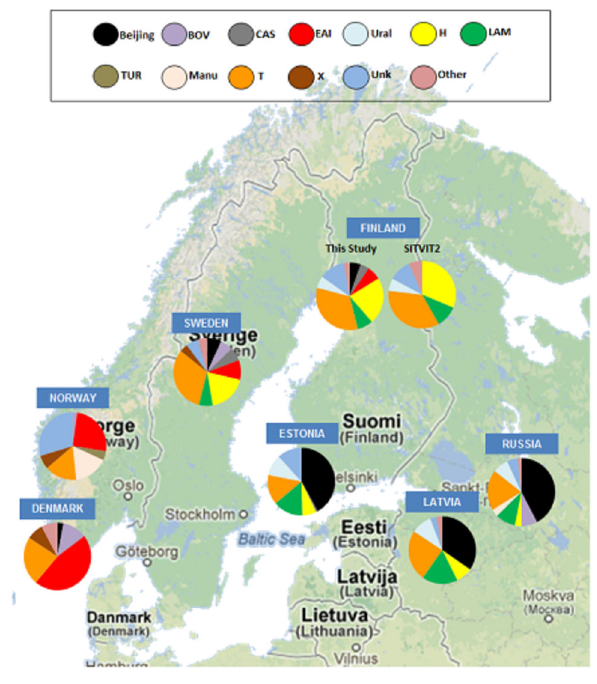
Figure 2. Phylogeographical distribution of M. tuberculosis lineages in neighboring countries. Colors of nodes depict the lineage of the strain. Note that the proportion of Ural lineage (notably Ural-1) is not negligible in the following countries: Russia, Latvia, Estonia, and Finland [11].